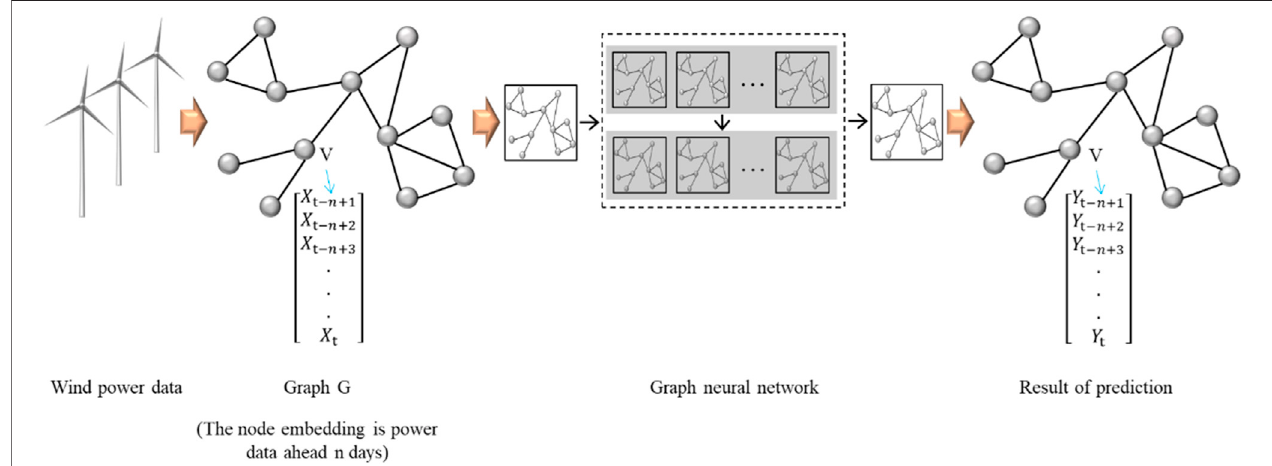
FIGURE 1 | Schematic diagram of the graph neural